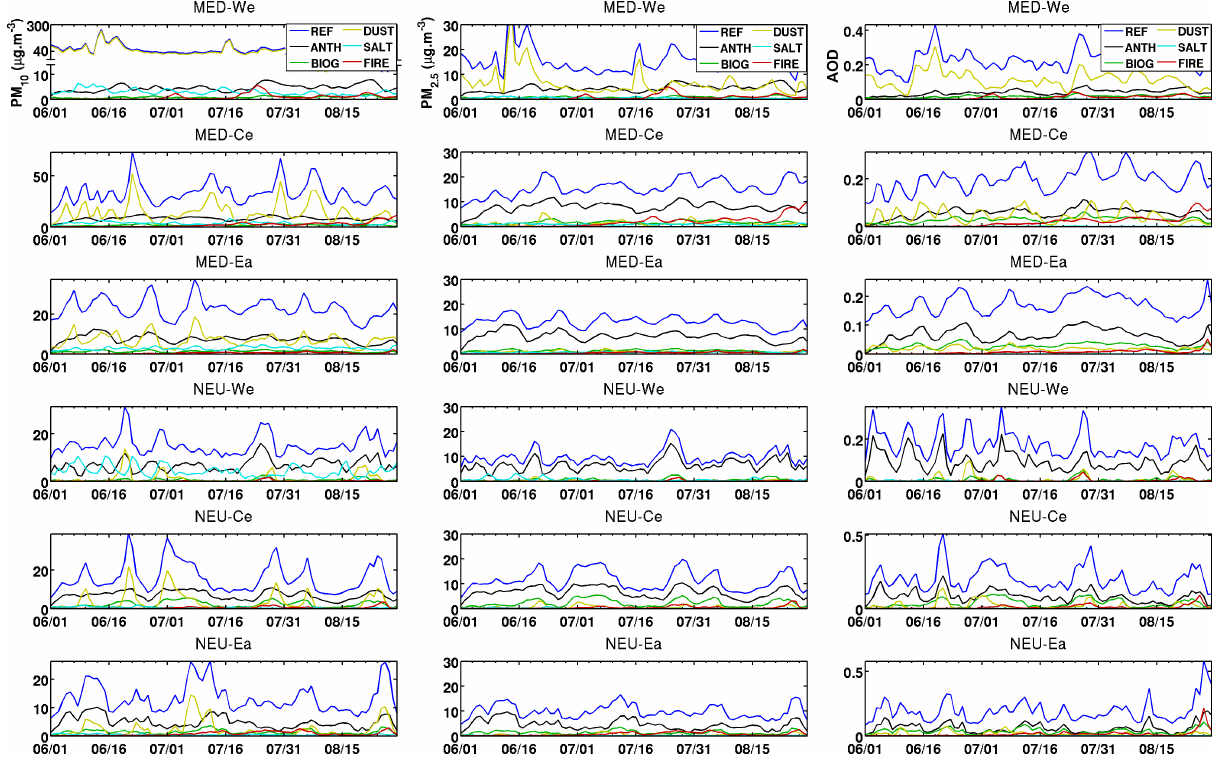
Figure 11. Temporal evolution during the summer of 2012 (1 June to 31 August 2012) of the total daily simulated surface PM 10 concen- trations (left column), surface PM 2 . 5 concentrations (central column), and AOD (right column), with the contributions from each source type (i.e., the baseline simulation minus the sensitivity simulation where the respective source has been eliminated), averaged within each sub-region indicated in Table